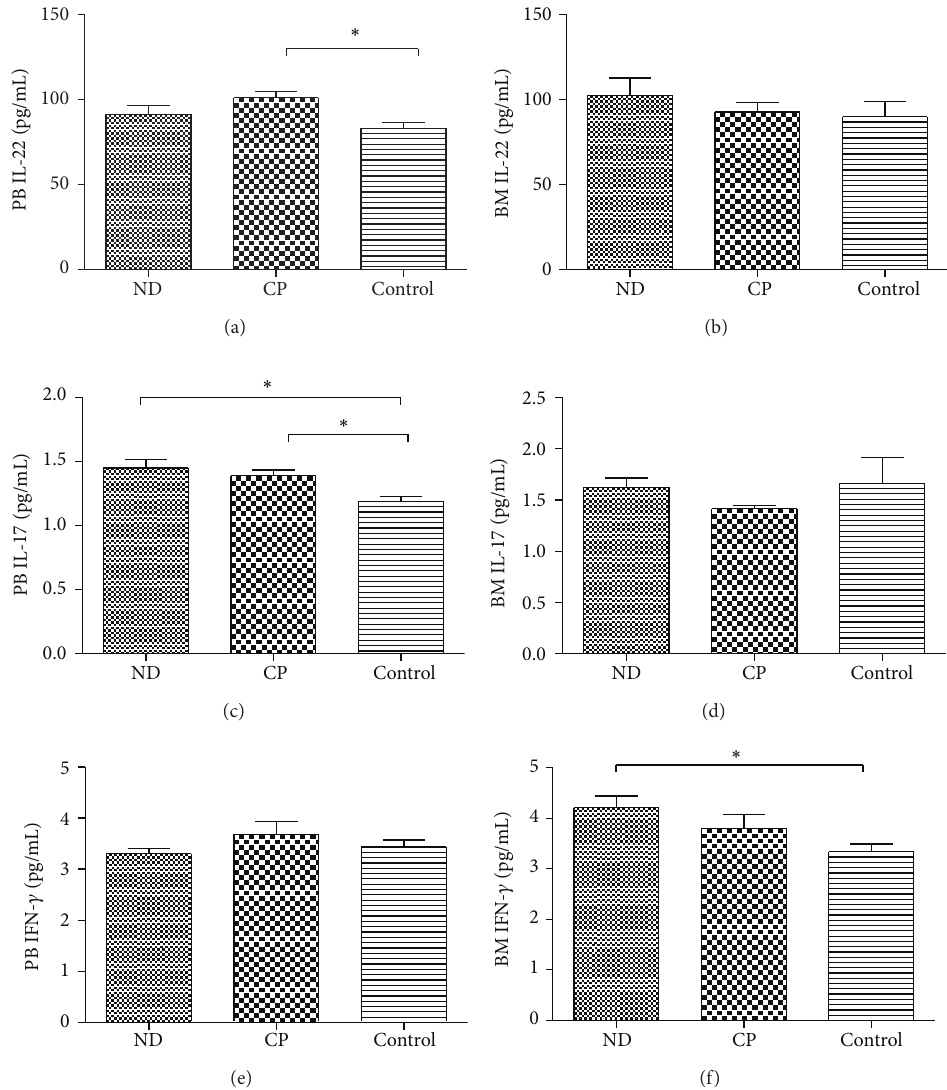
Figure 3: Concentrations of IL-22, IL-17, and IFN- 𝛾 in PB or BM plasma of CML patients and healthy controls. (a) Concentrations of IL-22 in PB plasma from CP ( ∗ 𝑃 = 0.001 ) patients were increased compared to in controls. No significant difference was found between ND and CP patients ( 𝑃 = 0.110 ) or controls ( 𝑃 = 0.194 ). (b) Concentrations of IL-22 in BM plasma from ND patients, CP patients, and healthy controls. No significant difference was found between ND ( 𝑃 = 0.575 ) or CP ( 𝑃 = 0.803 ) patients and healthy controls. (c) Concentrations of IL-17 in PB plasma from ND patients, CP patients, and healthy controls. The concentrations of PB plasma IL-17 in ND ( ∗ 𝑃 = 0.02 ) or CP ( ∗ 𝑃 = 0.01 ) patients were significantly higher than in healthy controls. There was no significant difference between ND and CP patients ( 𝑃 = 0.437 ). (d) Concentrations of IL-17 in BM plasma from ND patients, CP patients, and healthy controls. There was no significant difference between ND ( 𝑃 = 0.142 ) or CP ( 𝑃 = 0.645 ) patients and healthy controls. (e) Concentrations of IFN- 𝛾 in PB plasma from ND patients, CP patients, and healthy controls. No significant difference was found between ND ( 𝑃 = 0.711 ) or CP ( 𝑃 = 0.380 ) patients and healthy controls. (f) Concentrations of IFN- 𝛾 in BM plasma from ND patients, CP patients, and healthy controls. The concentration of BM plasma IFN- 𝛾 in ND patients ( ∗ 𝑃 = 0.015 ) was significantly higher than in healthy controls. There was no significant difference between ND and CP ( 𝑃 = 0.203 )